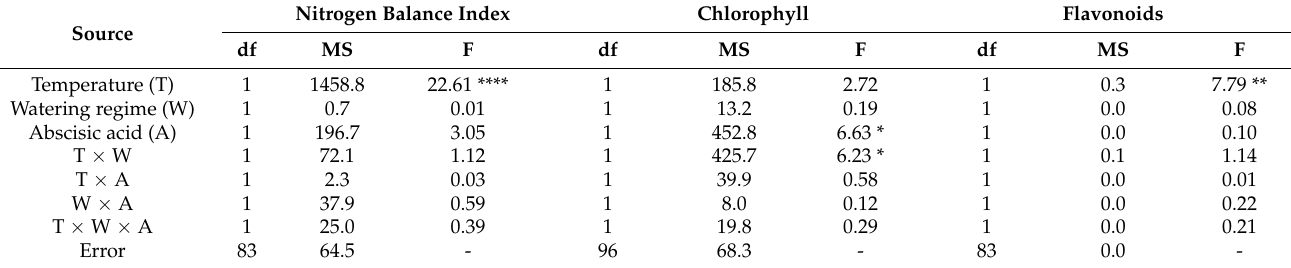
Table 17. Analysis of variance for the effects of temperature, watering regime, abscisic acid, and their interactions on the nitrogen balance index, chlorophyll, and flavonoids of tomato plants.